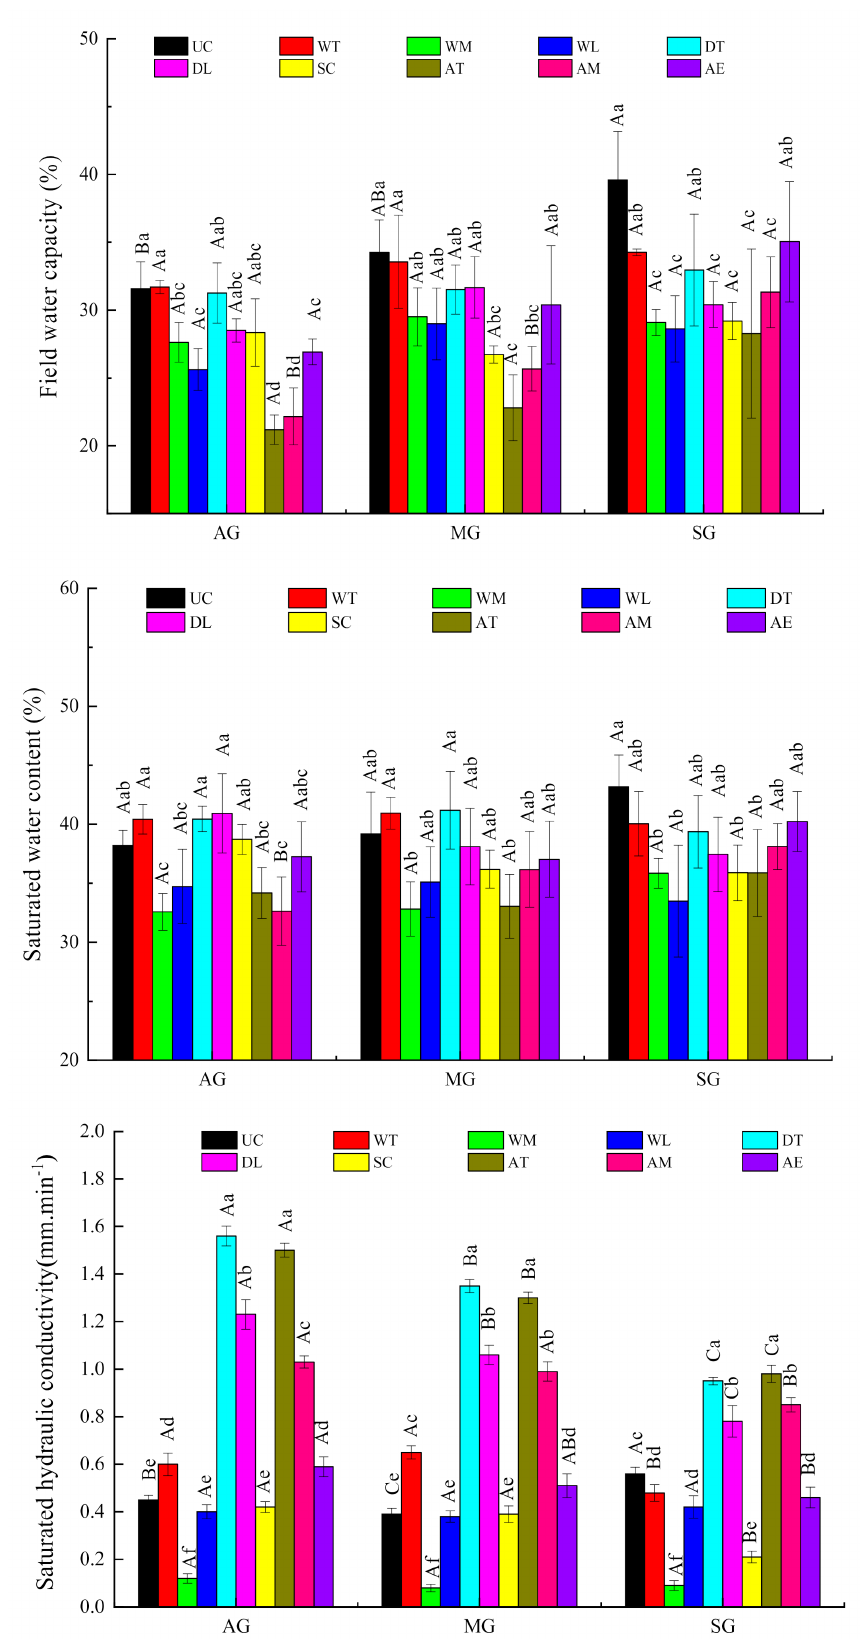
Figure 6. The field water capacity, soil water content, saturated hydraulic conductivity and pH in the different spatial positions in different stages of Benggang